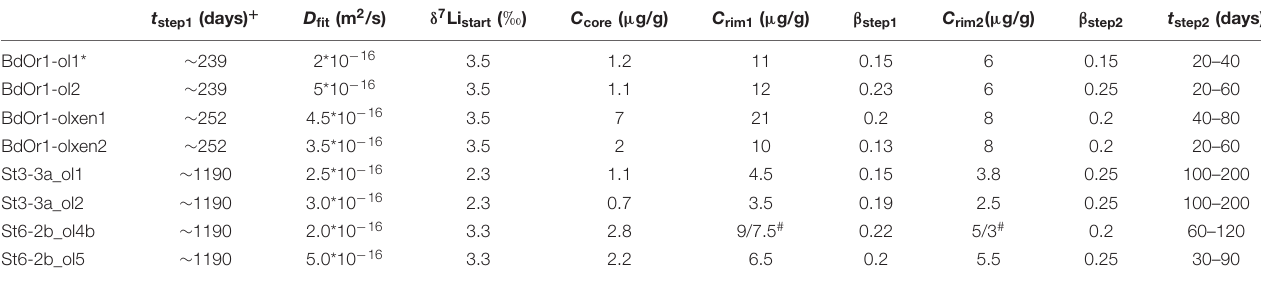
TABLE 2 | Modeling parameters of the first and second diffusion